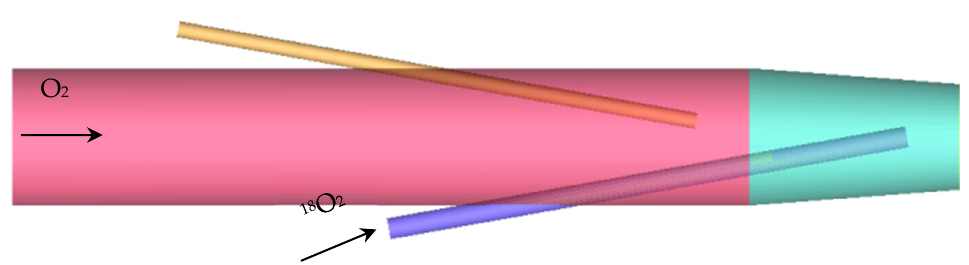
Figure 2. Schematic diagram of O 2 and 18 O 2.